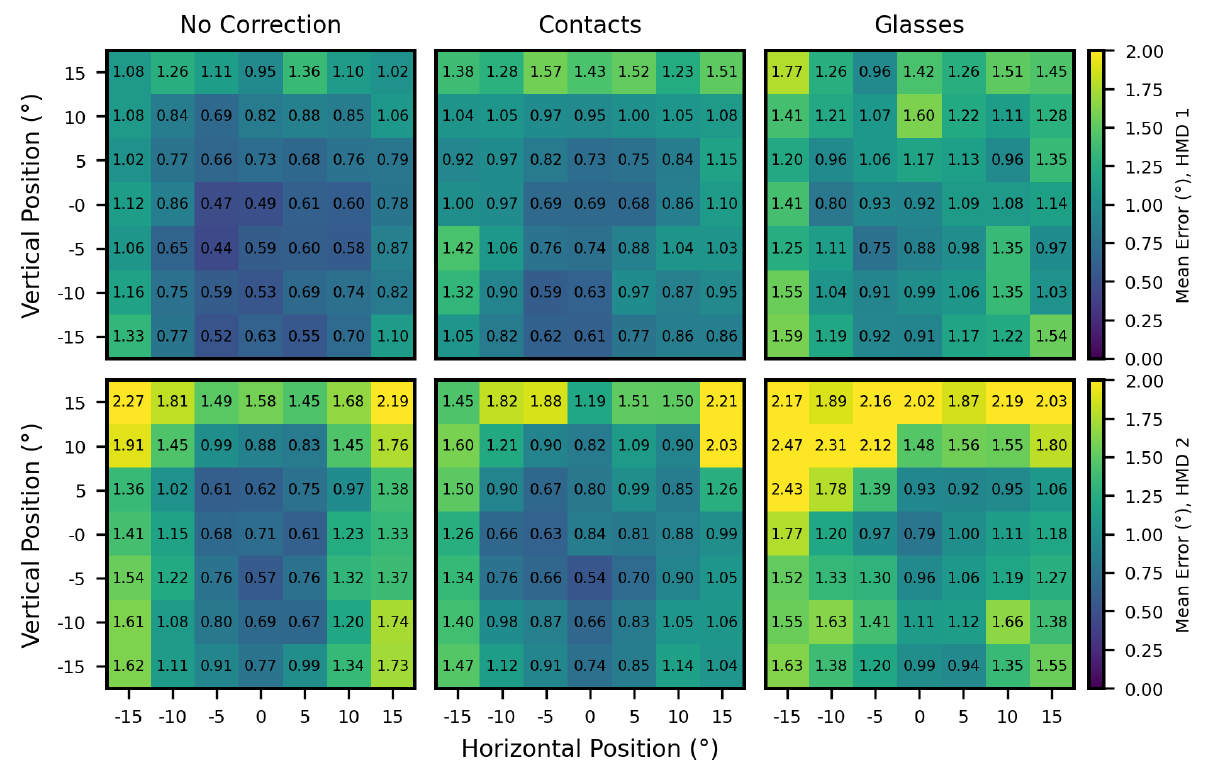
Figure 7. Average gaze accuracy at each presented target position across the FOV, split between HMD 1 (top row) and HMD 2 (bottom row), as well as by vision correction